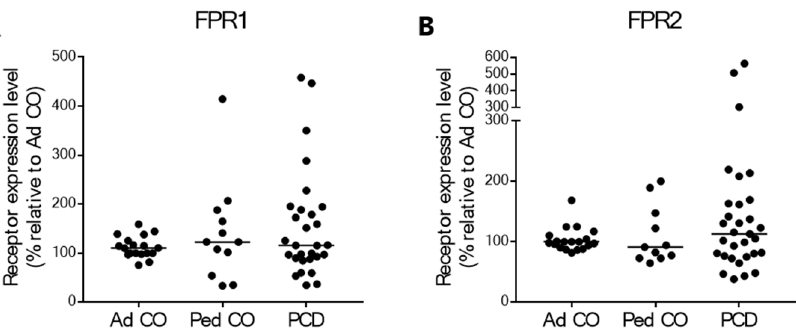
Figure 3. The chemoattractant receptors FPR1 and FPR2 are similarly expressed on peripheral blood PMNs from patients and healthy controls. The expression of fMLF receptors ( A ) FPR1 and ( B ) FPR2 on PMNs from patients with PCD ( n = 29–31 [21–23 pediatric and 8 adult]), age-matched healthy pediatric controls (Ped CO, n =11–12) and healthy adult controls (Ad CO, n = 18–19) was assessed by flow cytometry. The chemoattractant receptor expression levels (mean fluorescence intensity, MFI) were normalized to the levels on PMNs of the reference Ad CO (%). Each dot represents the normalized MFI of one patient or healthy control. No statistical differences in chemoattractant receptor levels on PMNs from patients and healthy controls were detected (Mann Whitney U-test).